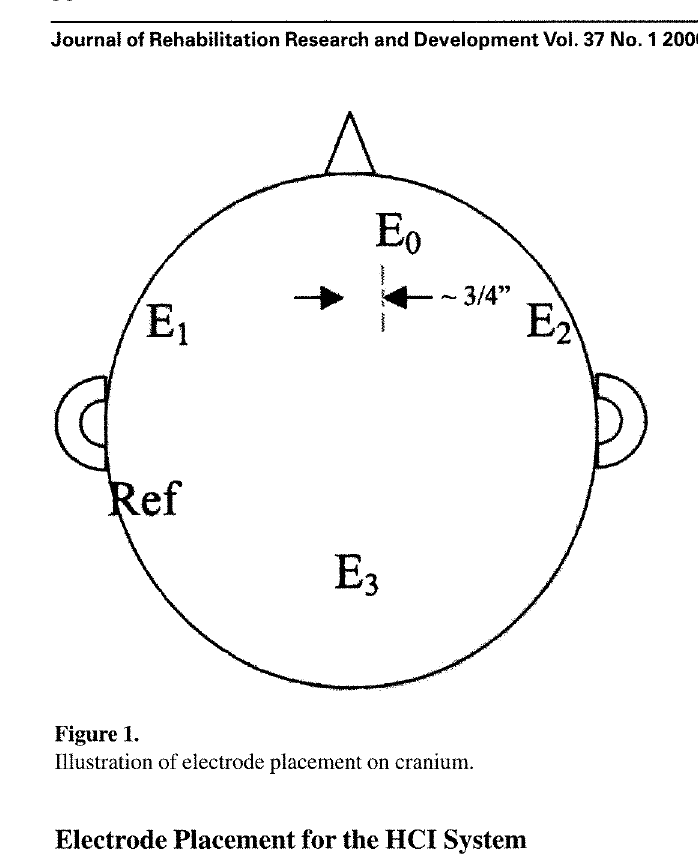
Figure 1. Illustration of electrode placement on